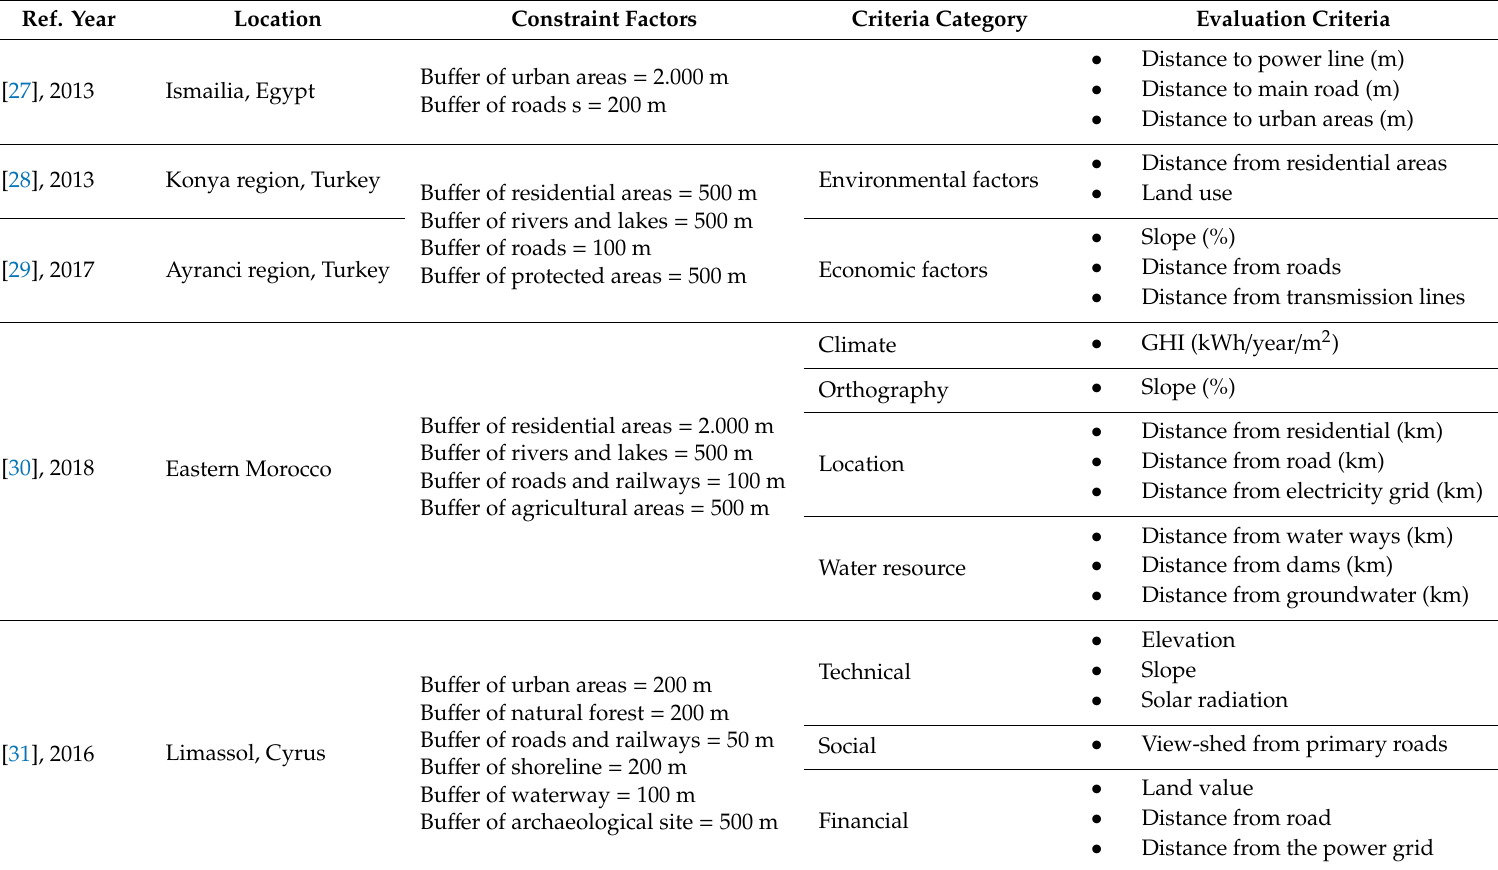
Table 1. Selected multi-criteria decision-making (MCDM) related studies for the selection of photovoltaic (PV) solar